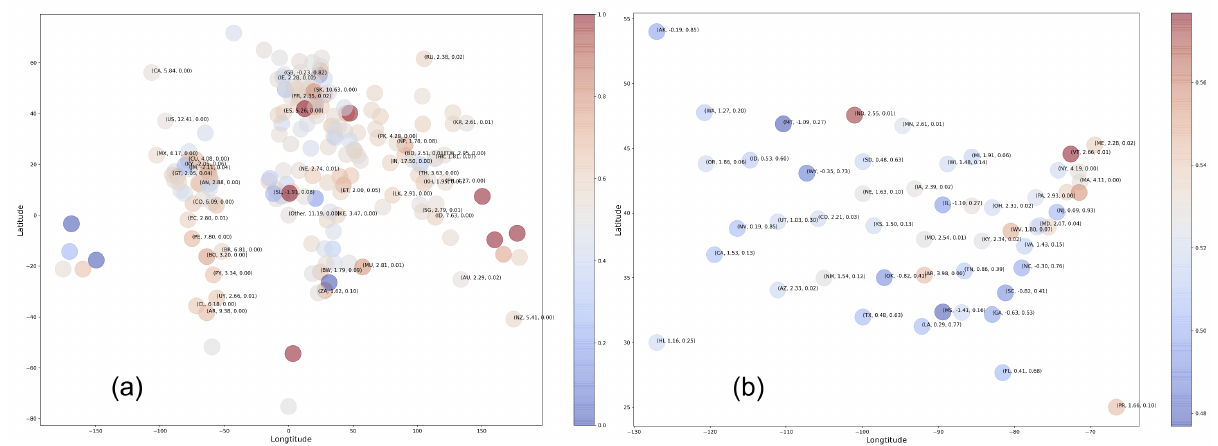
Figure 4. Visualization of the ( a ) countries and ( b ) US states based on latitude–longitude. The colors represent the fraction of positive tweets and annotations show ( t -statistic, p -value) for hypothesis that the mean positivity in tweet sentiment is > 0.5.